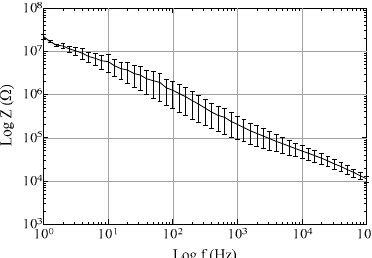
Figure 4. Impedance spectra of electrode sites with a diameter of 100 μ m in a phosphate-buffered saline solution. The error bars are standard error of mean.